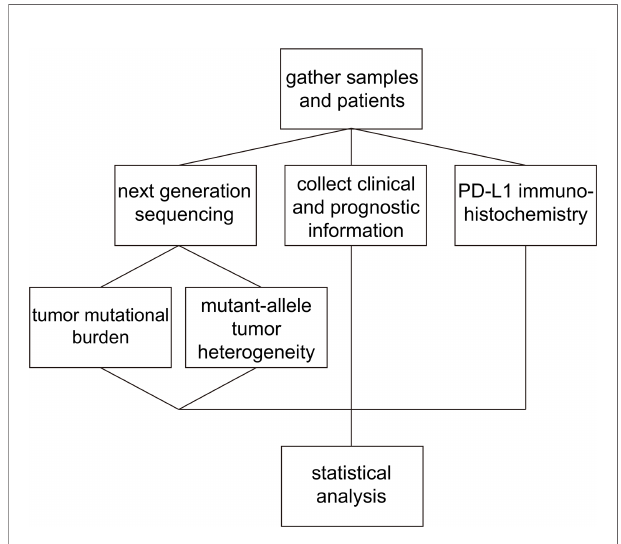
FIGURE 1 | Schematic of the experiment and analysis process. Firstly, we gathered patients and samples and collected clinical and prognosis information. We conducted NGS to calculate MATH and TMB value for patients and performed immunohistochemistry analysis to identify PD-L1 expression status. Then, statistical analysis was conducted to explore the predictive value of MATH in advanced lung